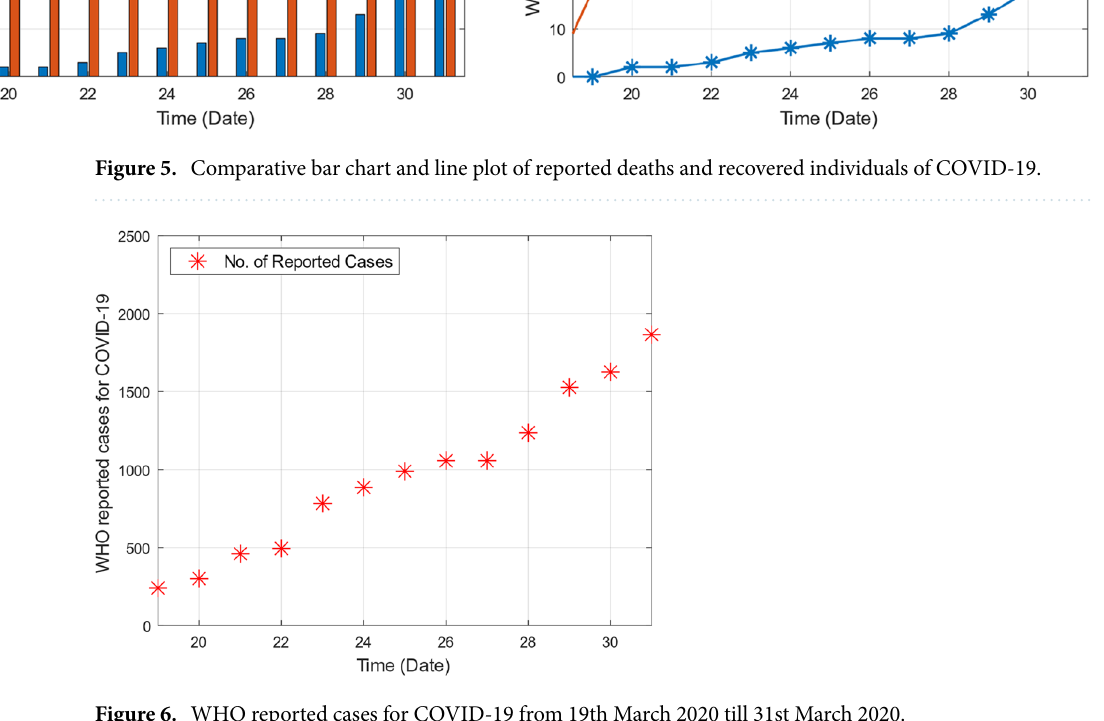
Figure 6. WHO reported cases for COVID-19 from 19th March 2020 till 31st March 2020.